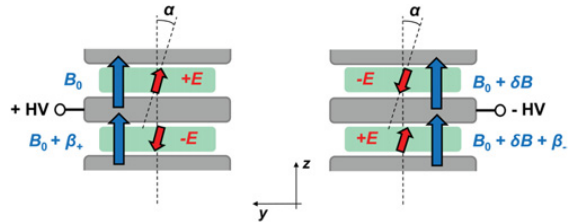
Figure 1. Scheme of the high voltage electrodes for the two different polarity settings (left: positive high-voltage and right: negative high-voltage). The two neutron beams, with their cross sections indicated by the green rectangles, are traveling between the electrodes in the x -direction. The angle α describes a potential misalignment between the electric and magnetic field. Here, δ B represents a global drift of the magnetic field between the two measurements, while β + and β − describe a systematic change of the magnetic field gradient.